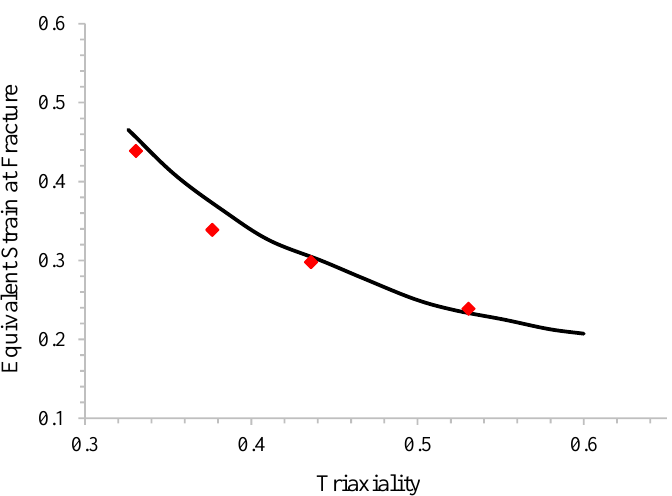
Figure 5. Relationship plot of strain to fracture and stress triaxiality: Flat specimens made of DC01 steel.